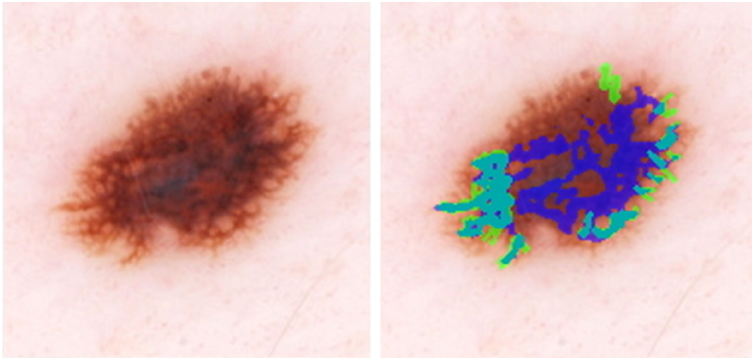
Figure 4. IoU = 0.29, close to the average IoU for all melanomas. DL detects peripheral irregular networks correctly. DL also detects normal network in the image center. Blue regions signify false-positive areas, green regions are false-negative, and teal-colored regions are